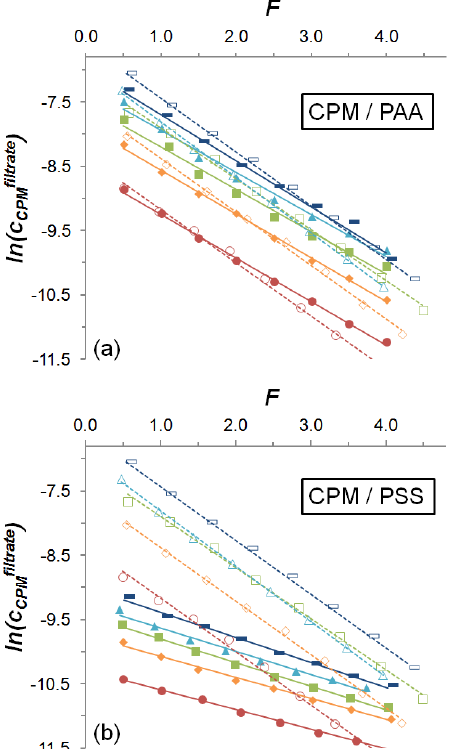
Figure 5. Diafiltration profiles of ( a ) PAA n /CPM n/2 and ( b ) PSS n /CPM n/2 systems at n = 0.50 (red circles), 1.0 (orange rhombuses), 1.5 (green squares), 2.0 (light blue triangles), and 2.5 (blue rectangles). Corresponding blank experiments made in the absence of polyelectrolytes are plotted as empty symbols. Table 1. WSP n /CPM n/2 system formulations, the resulting DF parameters, and the linear adjustment of the DF profiles with the corresponding linear regression factors ( R 2 ).